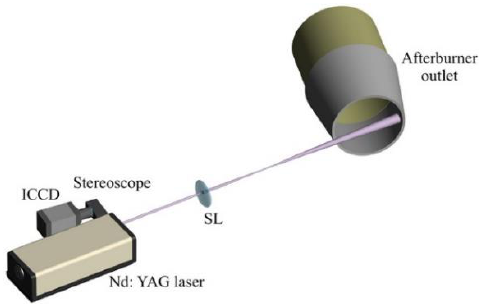
Figure 28. Experimental setup for two-dimensional wall temperature field measurements based on the LIP technology [34]. Reprinted with permission from [34]. Elsevier, 2011.